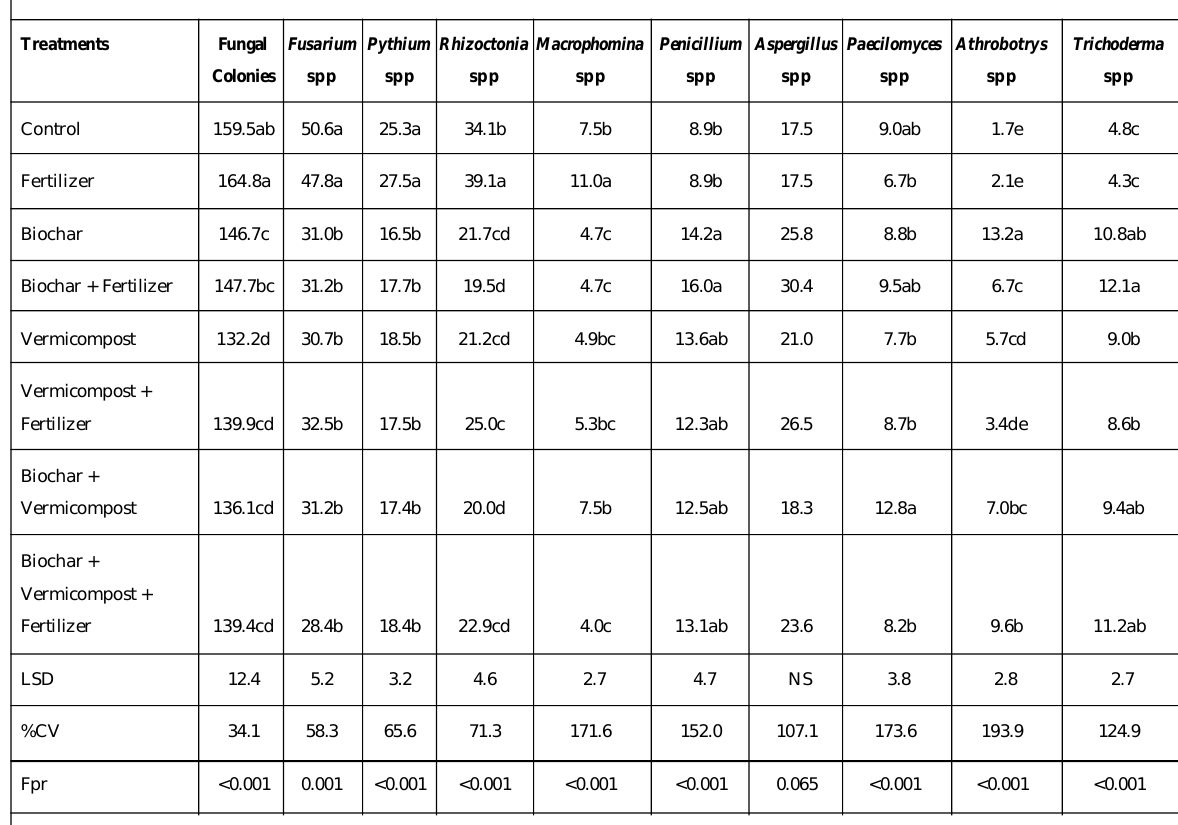
Fpr <0.001 0.001 <0.001 <0.001 <0.001 <0.001 <0.001 <0.001 <0.001 Note: Means with same letter(s) within the same column are not significantly different at p  0.05. NS: No significant difference, LSD: Least significant difference at 5% level, and CV: Coefficient of variation.